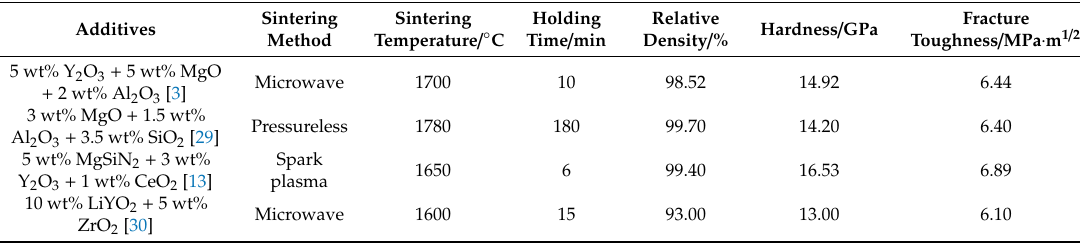
Table 3. Comparison of mechanical properties of silicon nitride.